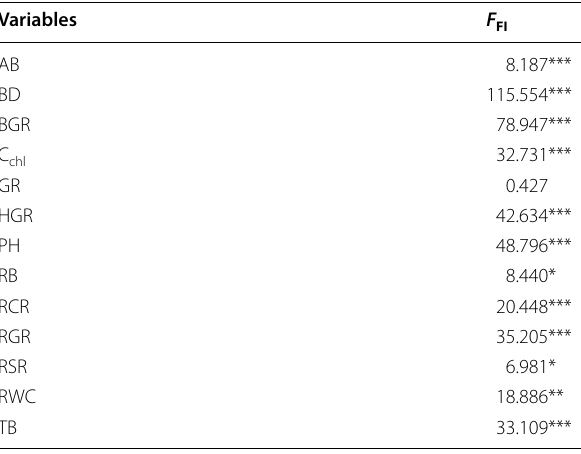
Table 1 One-way ANOVA for effect of fungal inoculation on variables of L. multiflorum seedlings